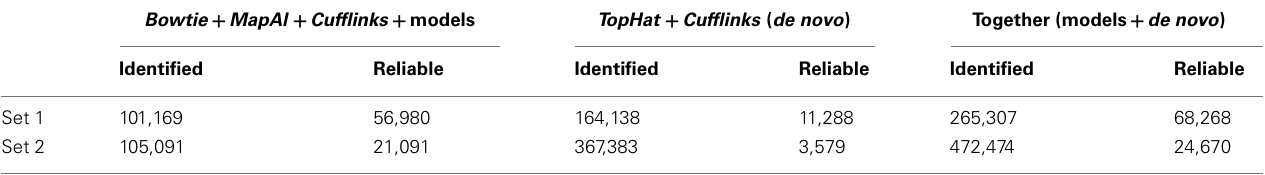
Table 3 | Statistics of identified and reliably measured transcripts, adding genes identified de novo .